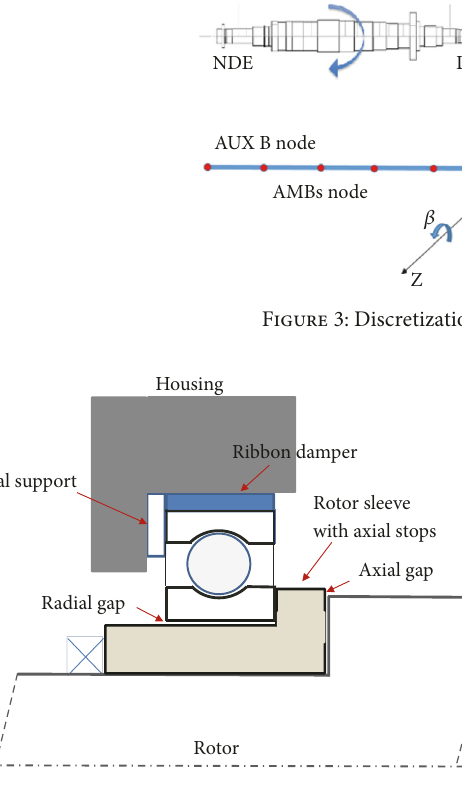
Figure 4: Schematic representation of the system axial